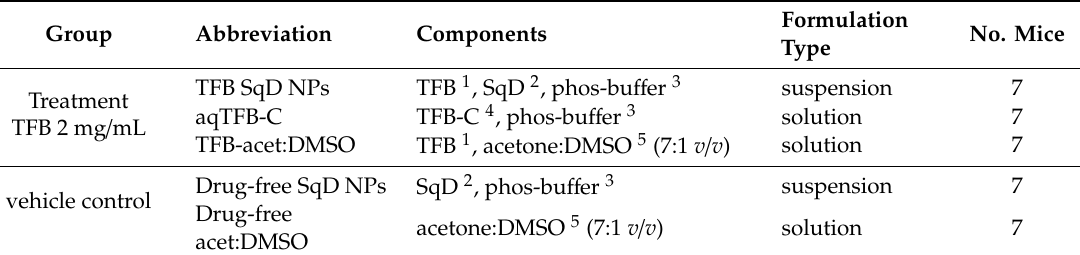
Table 2. Abbreviation, composition, formulation type, and number of treated mice of treatment and respective vehicle control groups for in vivo dermatitis mouse model study on biological response upon topical